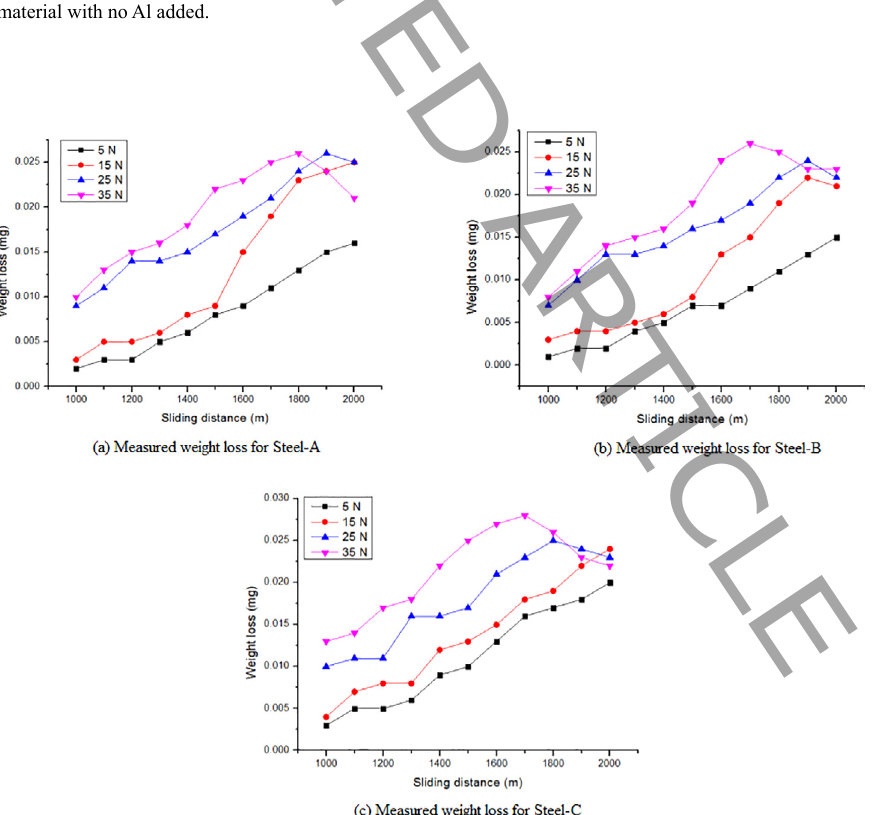
Figure 2. Weight loss at different load for: (a) Steel-A, (b) Steel-B and (c)